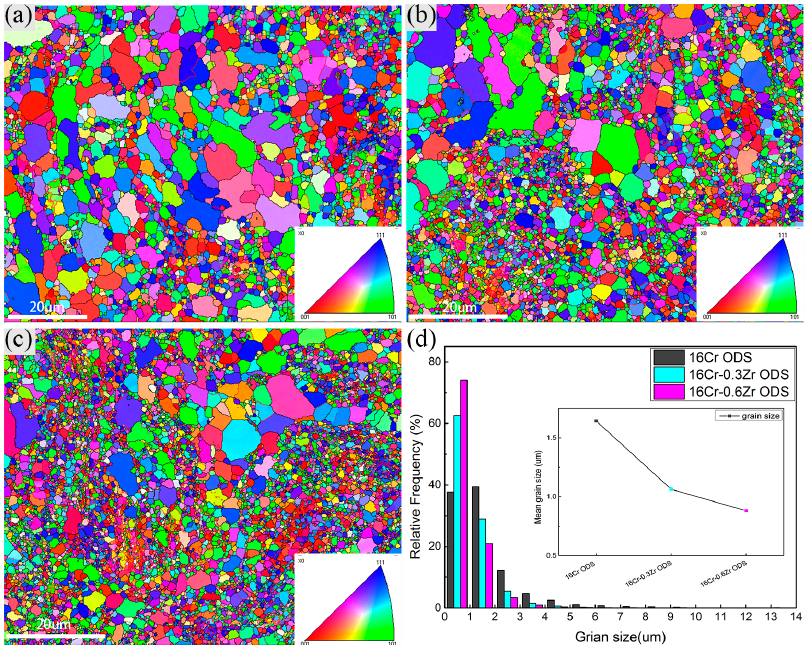
Figure 2. Inverse pole figure (IPF) and grain boundary maps of: ( a ) 16Cr ODS; ( b ) 16Cr-0.3Zr ODS; and ( c ) 16Cr-0.6Zr ODS steels; and ( d ) statistical results of grain size distribution in these three ODS steels.